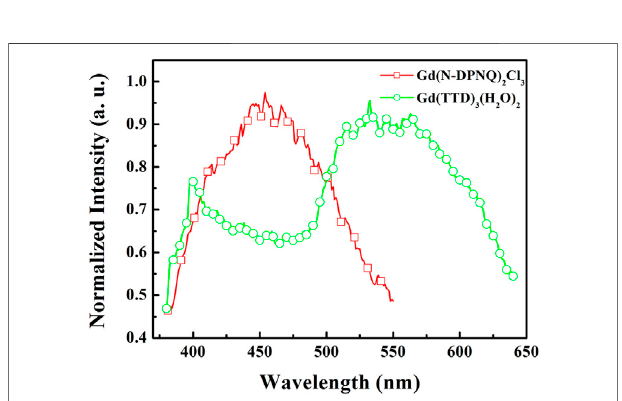
FIGURE 8 | Phosphorus spectra of Gd (N-DPNQ) 2 Cl 3 and Gd (TTD) 3 at 77 K.